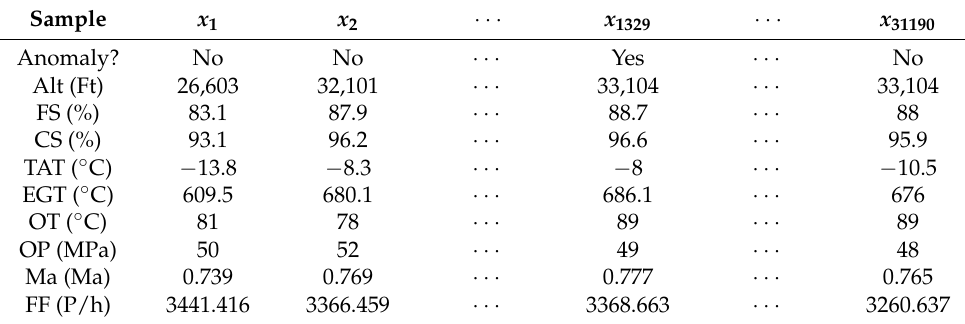
Table 2. Original gas-path parameters of civil